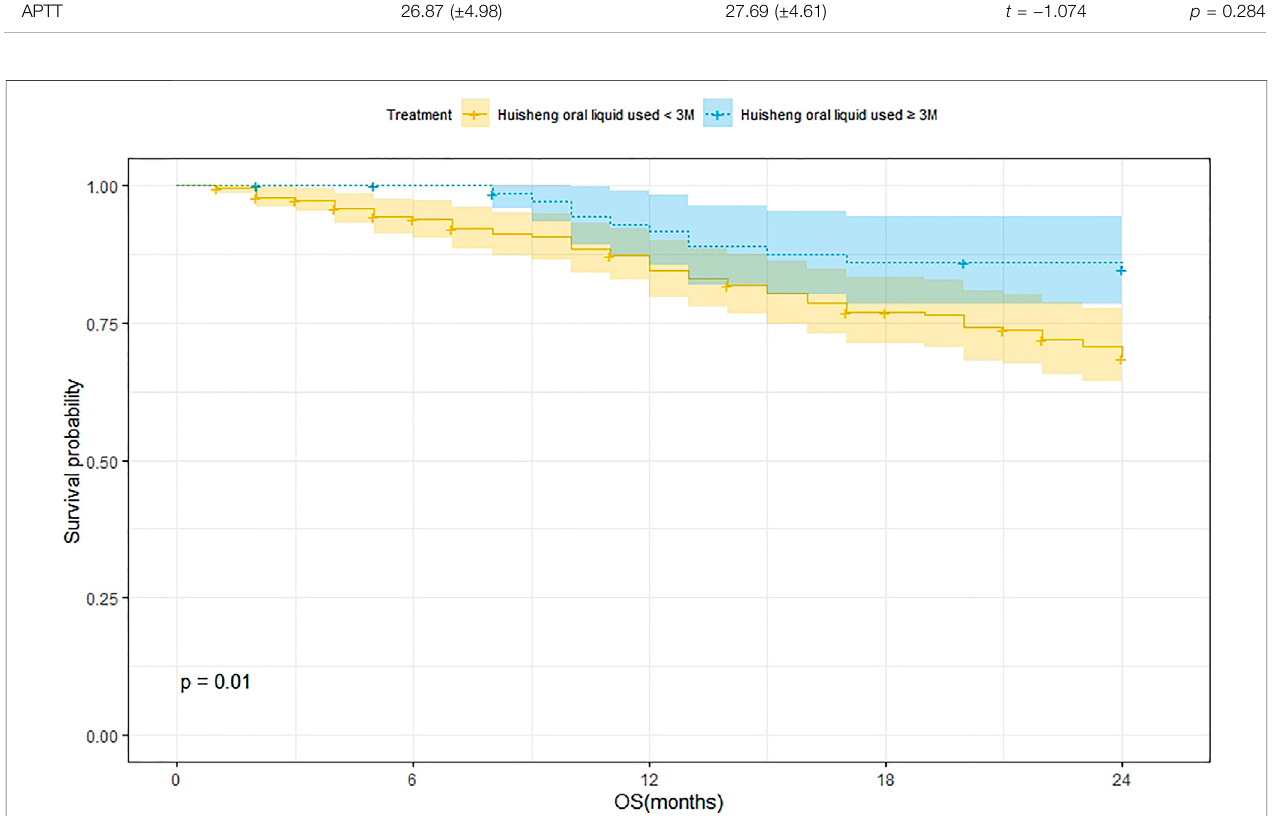
FIGURE 4 | Survival analysis of patients treated with HSOL for < 3 months and HSOL for ≥ 3 months.